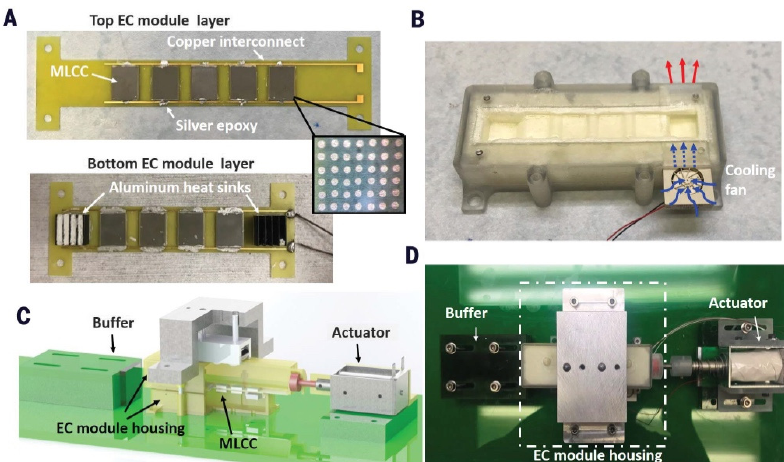
Figure 13. The electrocaloric device of Parc, a Xerox company: ( A ) The assembly of the EC elements; ( B ) the housing structure; ( C ) the 3-D model; ( D ) the realized architecture (reprinted with permission from [85], Science 2020).